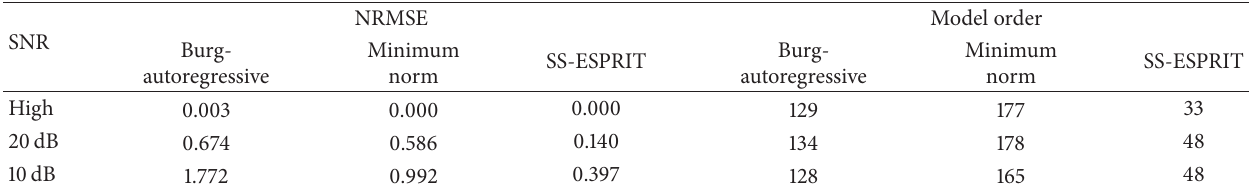
Table 1: Comparison of the NRMSEs of different methods at different